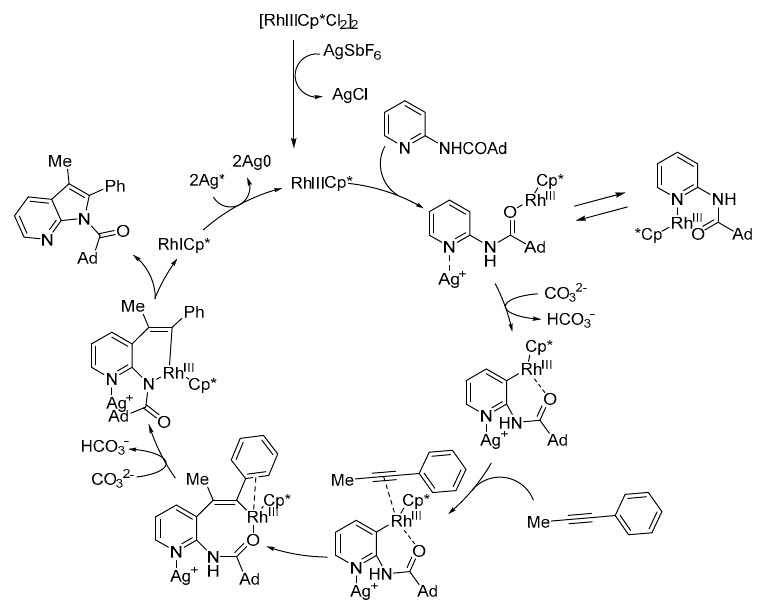
Scheme 21. Synthesis of azaindoles ( 51 ) from alkynes and N-substituted aminopyridines ( 49 ) using Rh(III) catalysis [34].